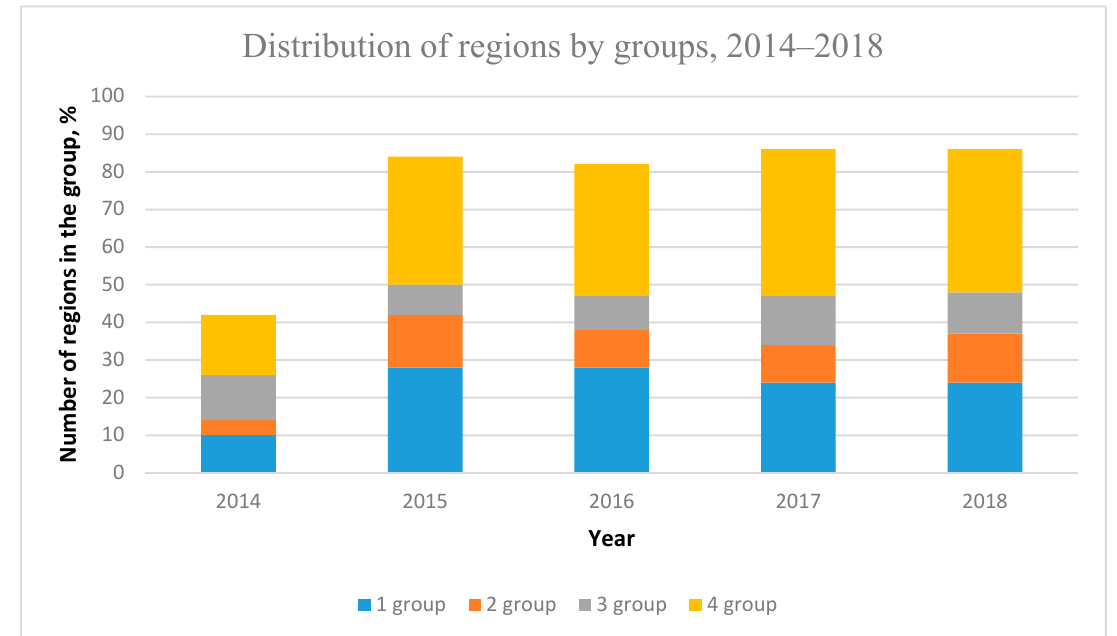
Figure 2. Distribution of regions by groups, 2014–2018.